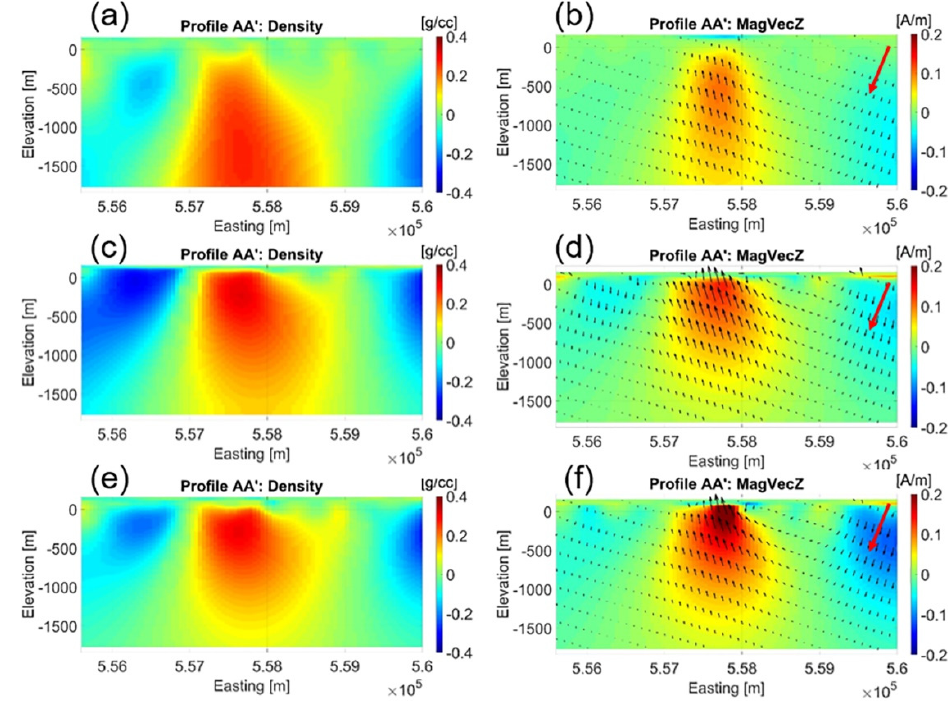
Figure 7. Panels ( a , b ) show vertical sections of the 3D density and magnetization vector models obtained from standalone inversions, respectively. Panels ( c , d ) show vertical sections of the 3D